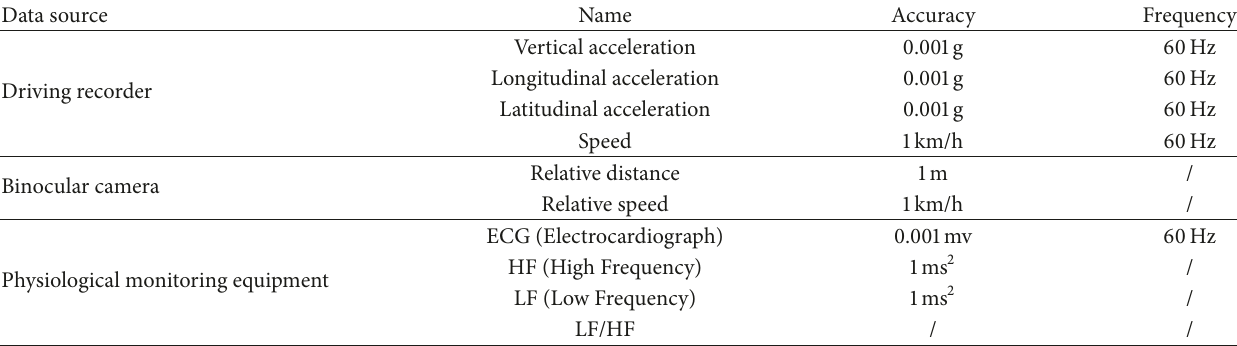
Table 2: Data collection